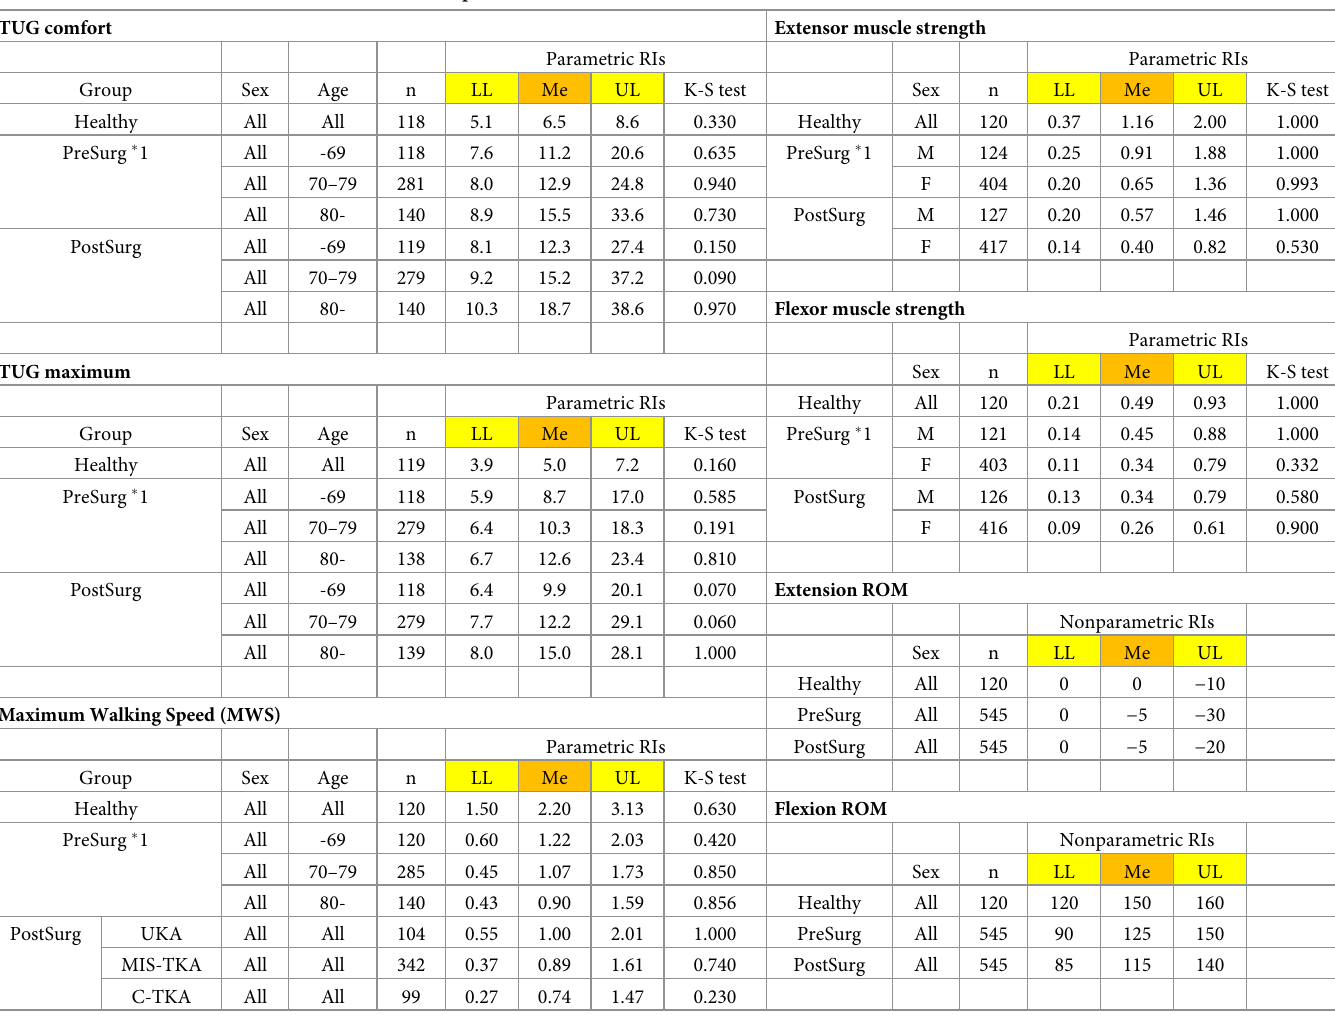
Table 4. Reference intervals derived for motor function parameters. TUG